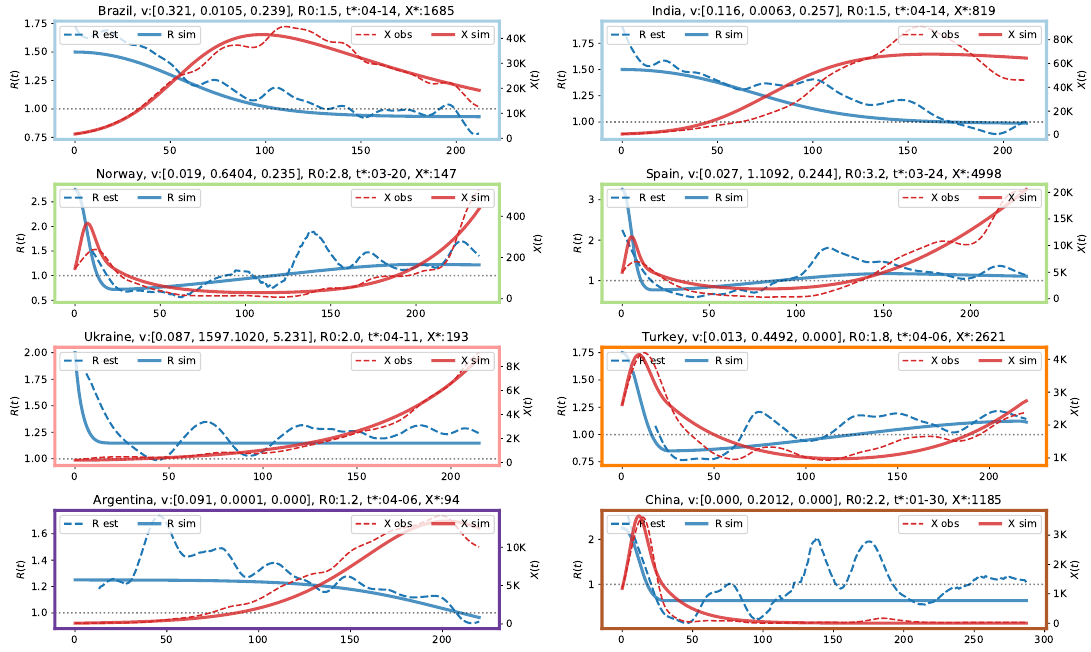
Figure 7. Comparison between observed daily cases X ( t ) (red dashed lines), X ( t ) simulated from ( t ) estimated from the data using the inverted SIR model (dashed blue line), model (solid red lines), R ( t ) simulated from the R